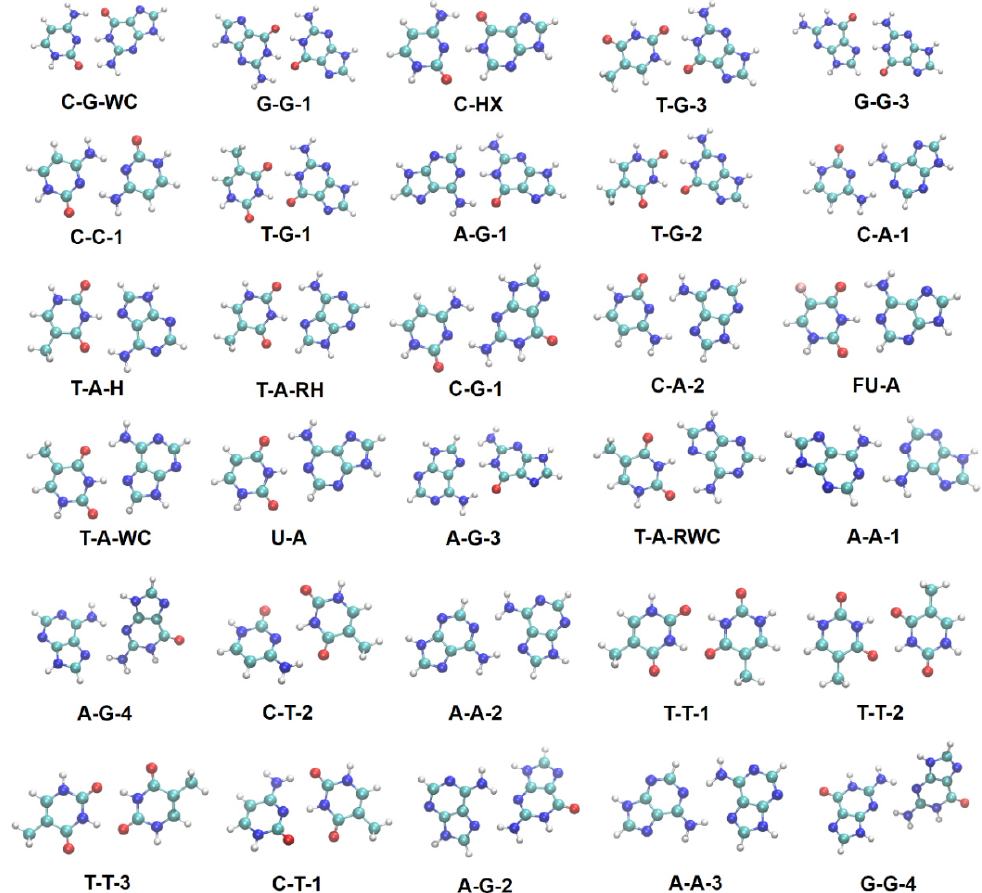
Scheme 1. Optimized structures of the 30 base pairs. Color code: H in white, C in cyan, N in blue, O in red, and F in pink.